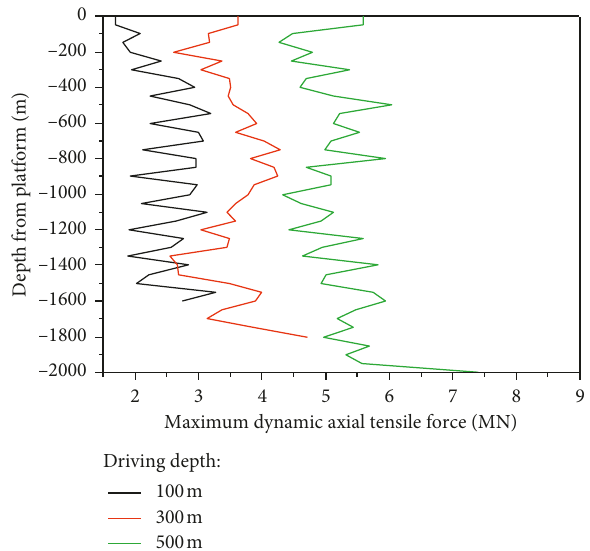
Figure 27: Effect of driving depth on maximum dynamic axial tensile force.